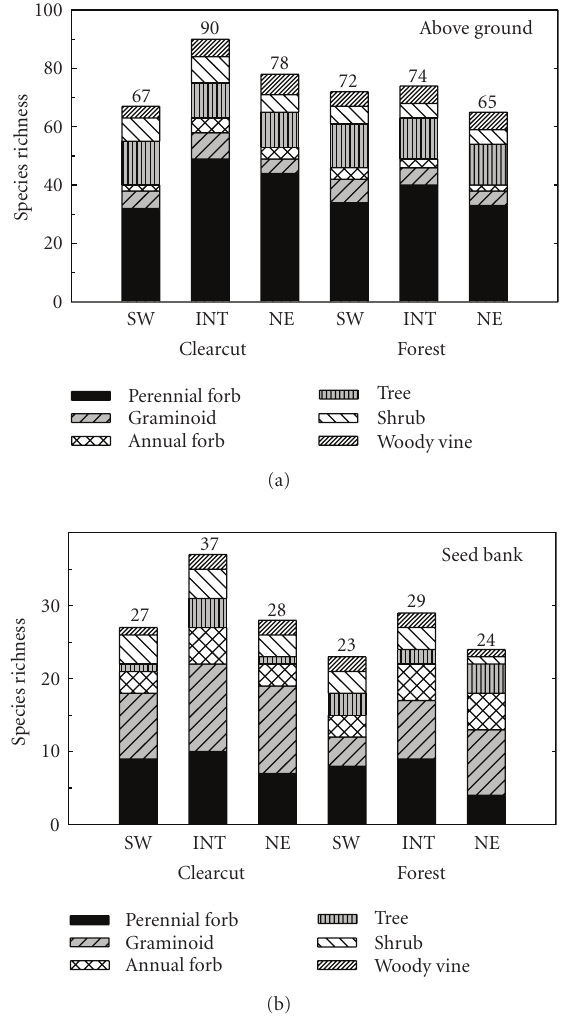
Figure 3: Aboveground and seed bank richness by life form in revegetating clearcut and second-growth forest samples at southwest (SW), intermediate (NW/SE; INT), and northeast (NE) aspect positions at WWRS. Note di ff erent scales of y -axes. See text for definitions of stand type/aspect classes. Life form designations follow Gleason and Cronquist [48].